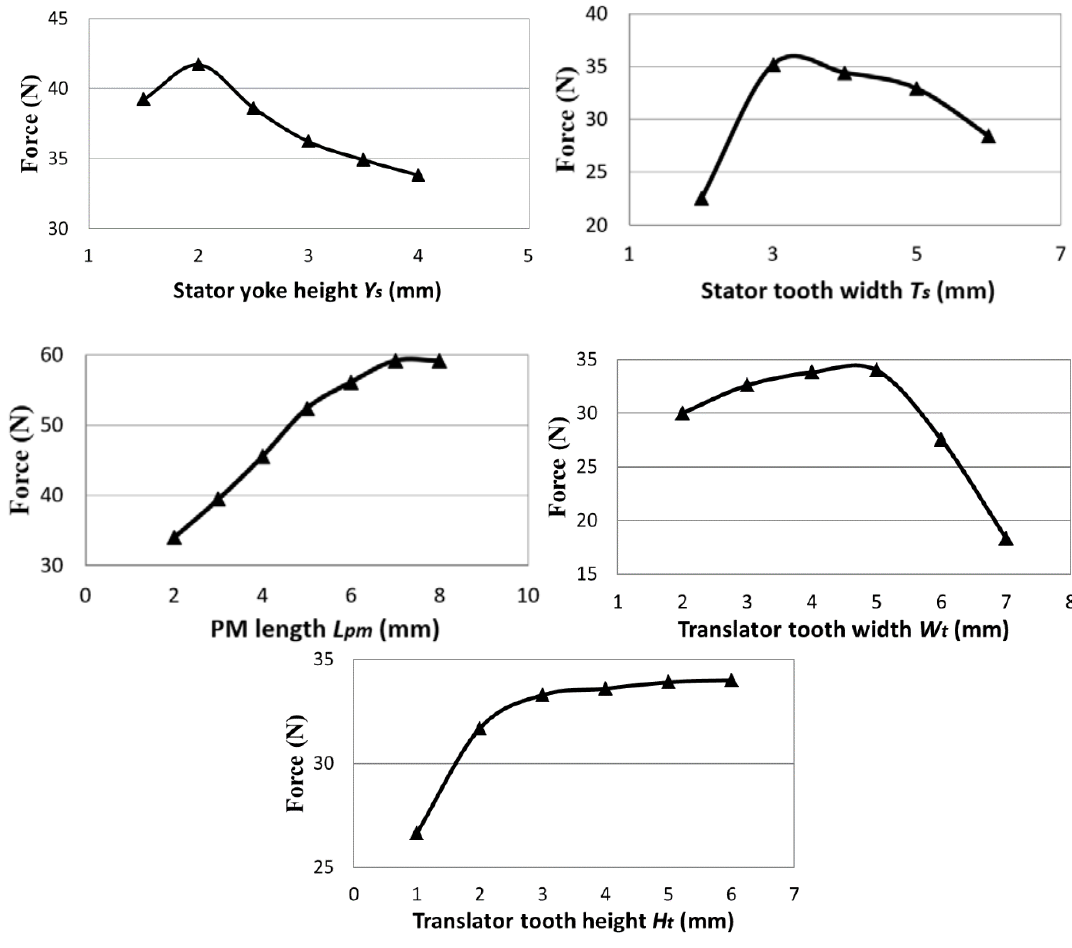
Figure 5. Parametric analysis of geometric variables.